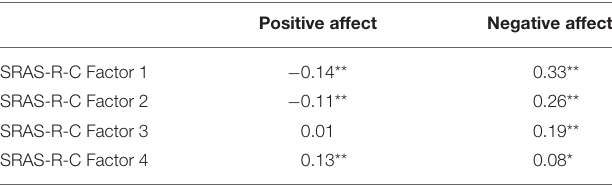
TABLE 2 | Correlations between affect and school refusal behavior.